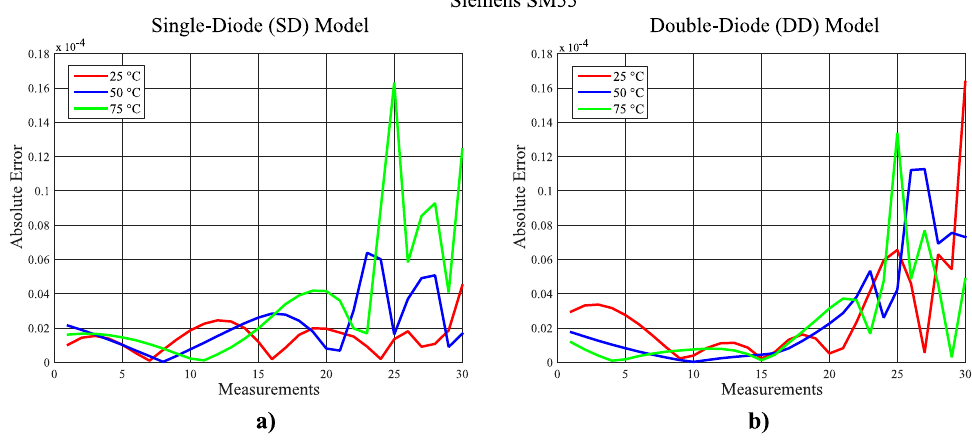
Figure 13. Absolute error curves between the measured and experimental I-V data at different cell temperatures (25, 50 and 75 ◦ C) and fixed solar irradiance ( G = 1000 W/m 2 ) for an individual cell from a Siemens SM55 Solar Panel. ( a ) SD model and ( b ) DD model.